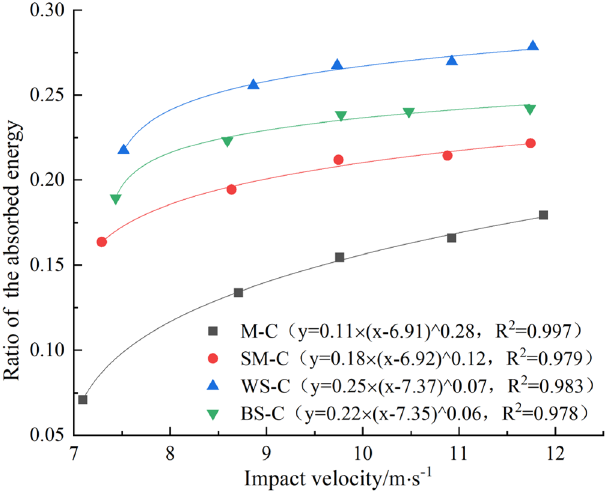
Figure 10. The relationship between impact velocity and ratio of the absorbed